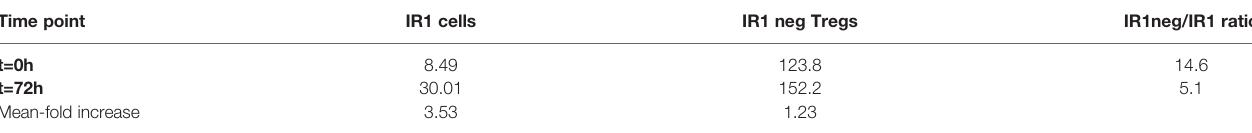
(21) was selected based on binding af fi nity and speci fi city for TIRC7 ( Supplementary Figure 3 ). It demonstrated speci fi c binding to TIRC7 expressed in COS7 cells ( Supplementary Figure 3A ) or to wild type mice (+/+) but not to TIRC7 de fi cient mice splenocytes (-/-) and ( Supplementary Figure 3B , left panel) with an af fi nity at 200 – 300 pM. TIRC7 antibody was used to expand and isolate IR1 cells from puri fi ed Tregs obtained from 3 healthy subjects and to characterize the number of TIRC7+Tregs (IR1 cells) in the culture via fl ow cytometry. Incubation with this antibody plus IL-2 induced TIRC7+ IR1 Tregs to over 30%, substantially exceeding induction via IL-2 only ( Figure 3A ). Stability of the IR1 Treg phenotype was examined for these subjects after 14 days expansion ( Figure 3B ). High expression levels of LAP, CD39, GARP, FOXP3 and IL-10 were also maintained after two weeks expansion in IR1 cells ( Figure 3C ). To evaluate the overall immunosuppressive activity of the 14-days expanded and puri fi ed IR1 cells, we assessed their ability to inhibit cell proliferation in a mixed lymphocyte reaction (MLR) as compared to IR1neg Tregs. Human T- effector cells (Teff) and allogeneic dendritic cells (DC) were stimulated in an MLR under three conditions: (1) Teff + DC + IR1 cells; (2) Teff + DC +IR1neg Tregs; (3) Teff + DC (control). IR1 cells reduced proliferation by 80% compared to the control without Tregs, while IR1neg Tregs showed only a 50 percent reduction. Thus, IR1 cells show greater functional suppression compared to IR1neg Tregs ( Figure 3D , from left to right).